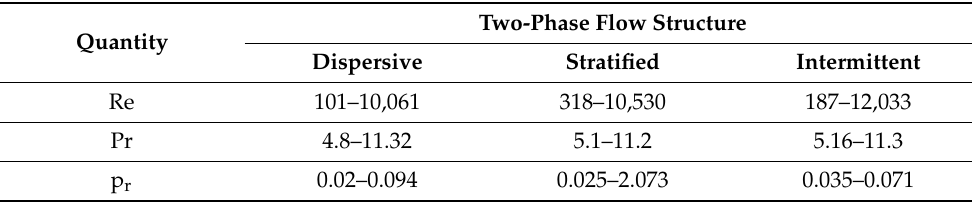
Table 5. Range of Reynolds number Re, Prandtl number Pr and reduced pressure pr values in which the correlation was checked